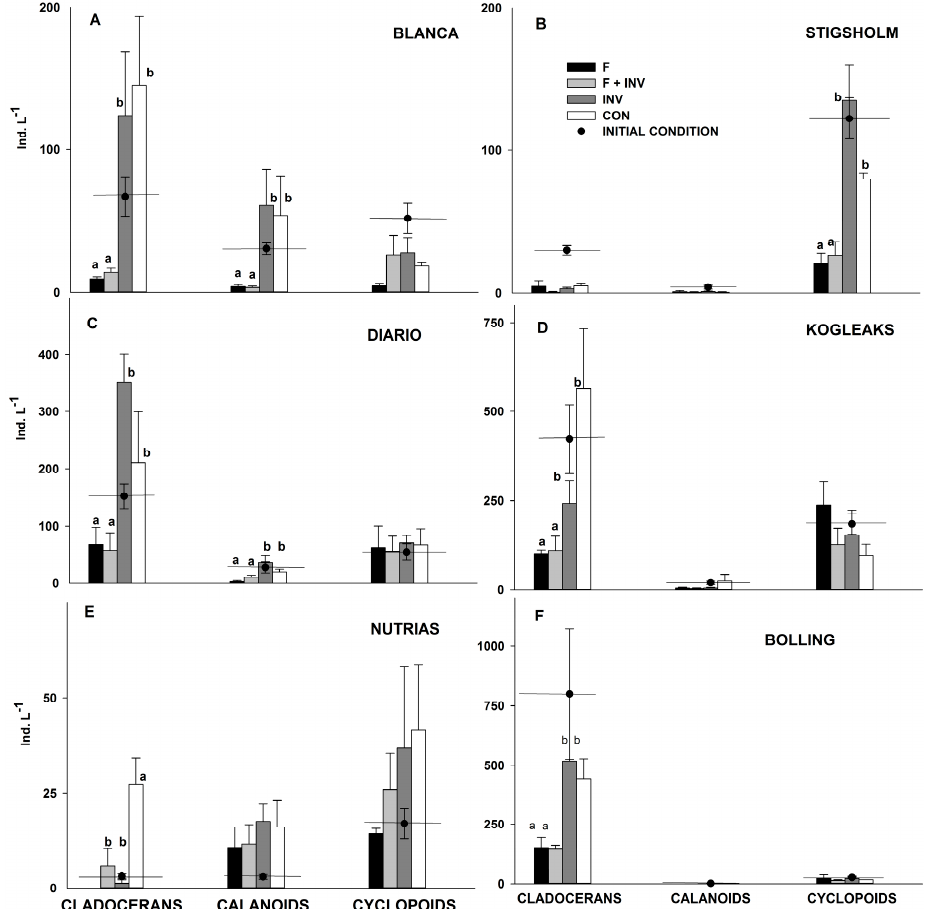
Figure 2. Effects of experimental treatments on the abundance of zooplankton in subtropical (pannels A , C and E ) and temperate (panels B , D and F )) lakes. Dotted and horizontal lines represent the initial conditions (just before treatment assignment and 15 days after fish exclusion), while columns show the final conditions (49 days after fish and macroinvertebrate addition). F (fish); F + INV (fish + predatory macroinvertebrates) and INV (predatory macroinvertebrates). Error bars represent ±1 standard error. Please note the different scales on the y -axes. Letters indicate groups based on Tukey’s post hoc tests when ANOVA tests were